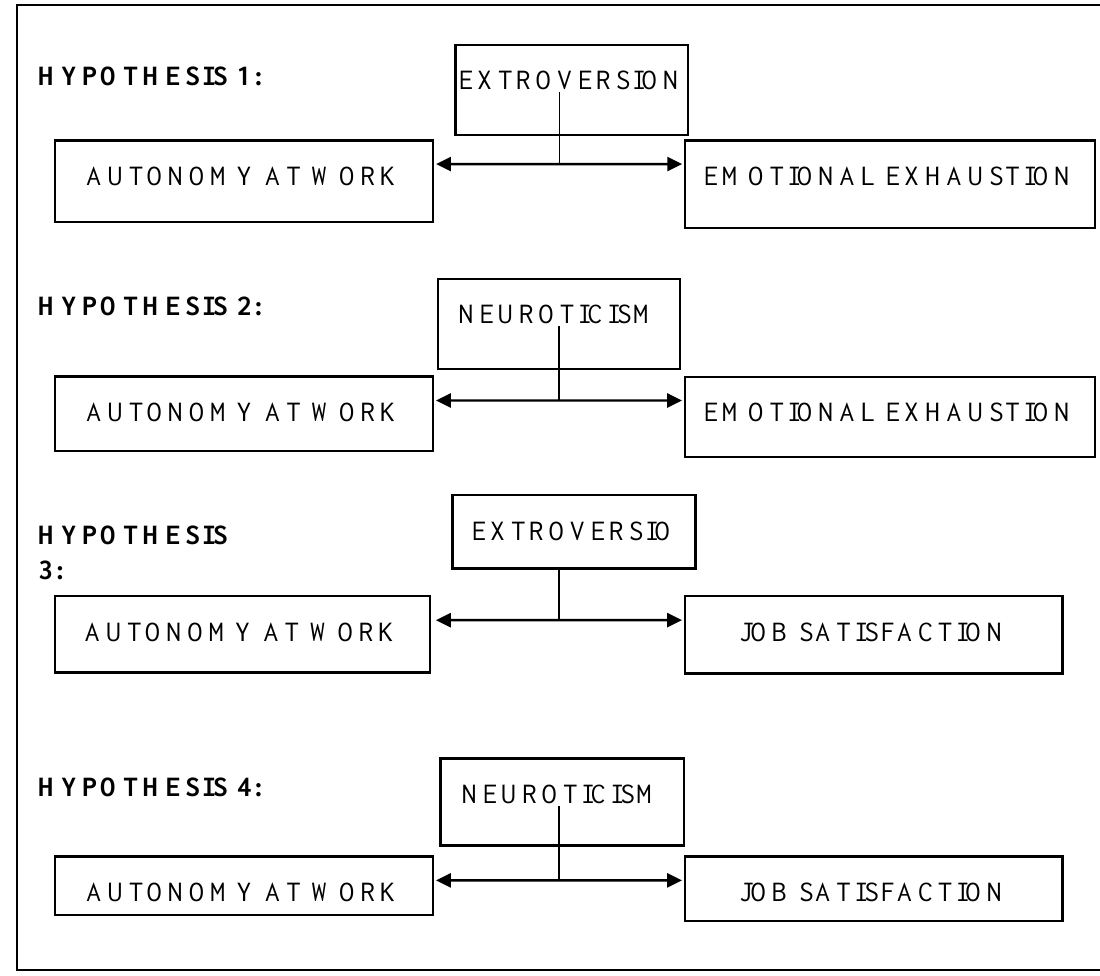
Figure 1. Study hypotheses.